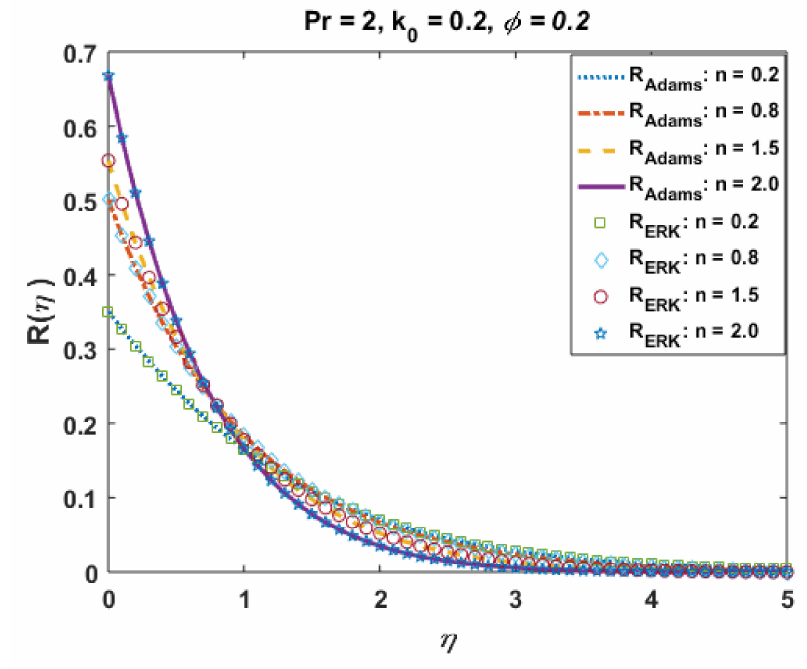
qualitatively similar to those of Al 2 O 3 .